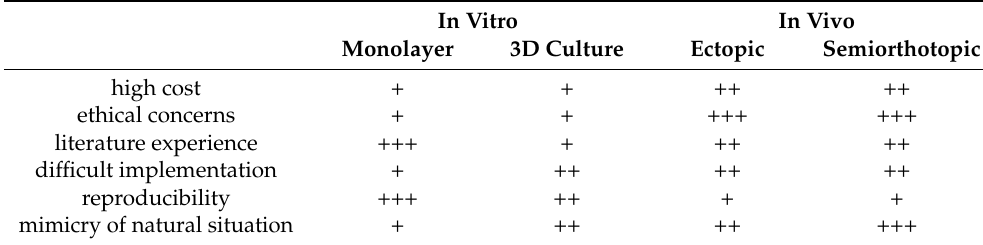
Table 1. Strengths and weaknesses of in vitro and in vivo